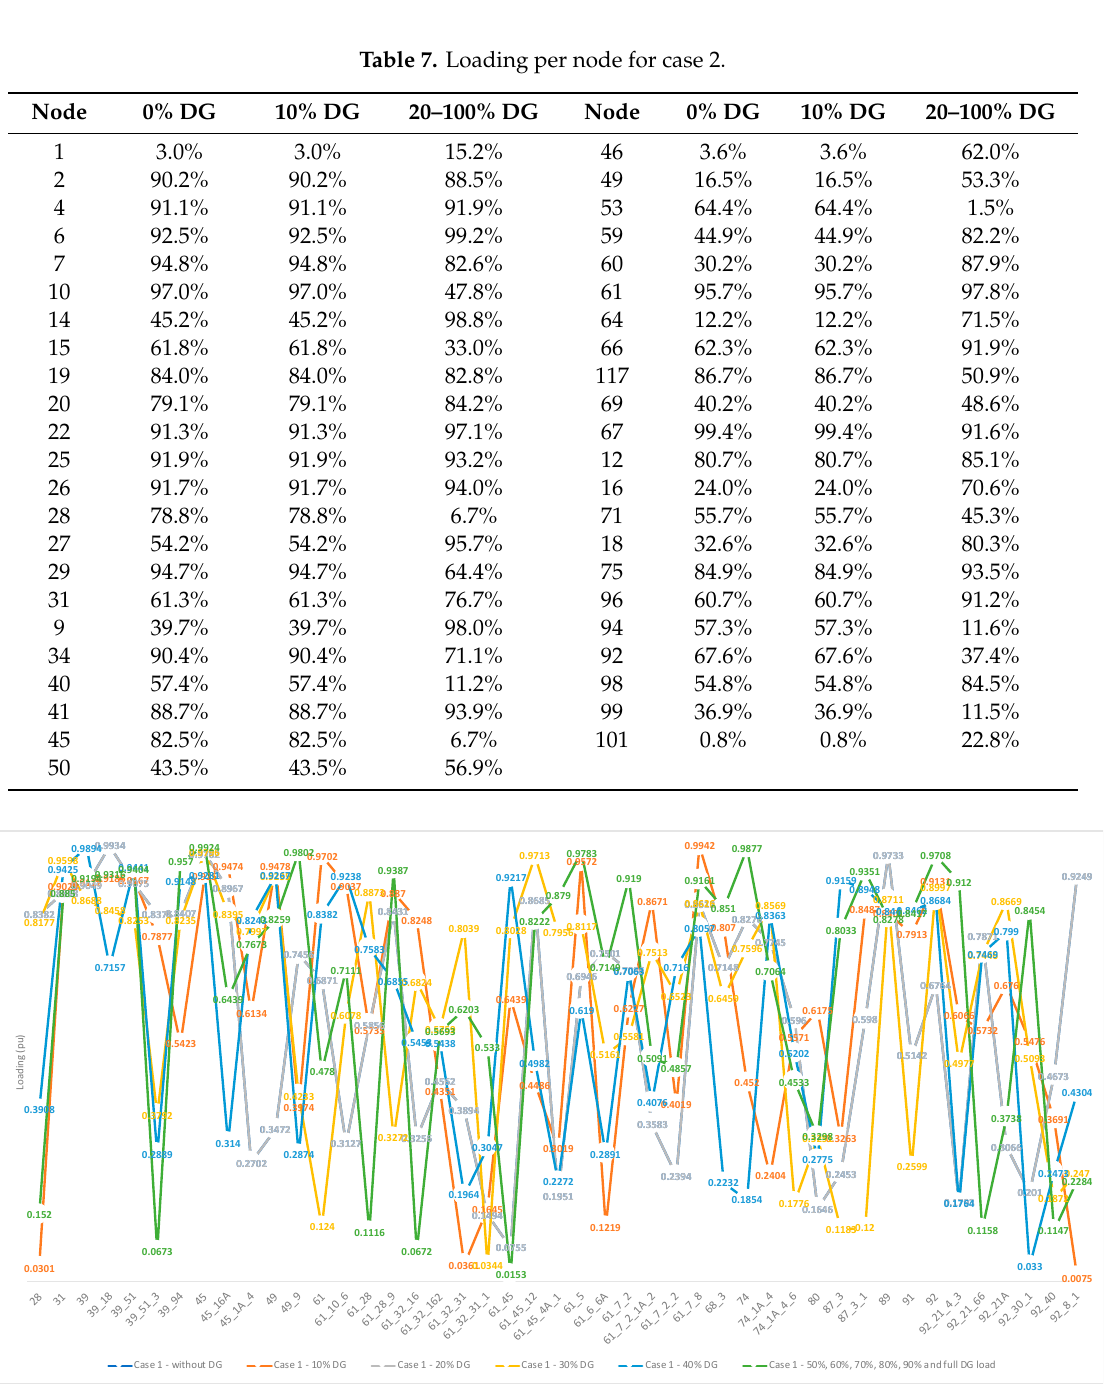
Figure 4. Graphic representation of the loading per node for case 1. Table 7. Loading per node for case 2.